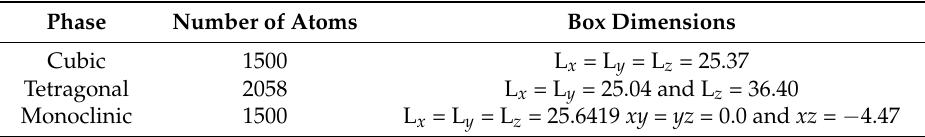
Table 1. Dimensions and number of atoms in the simulation box for cubic, tetragonal, and monoclinic HfO 2 . Phase